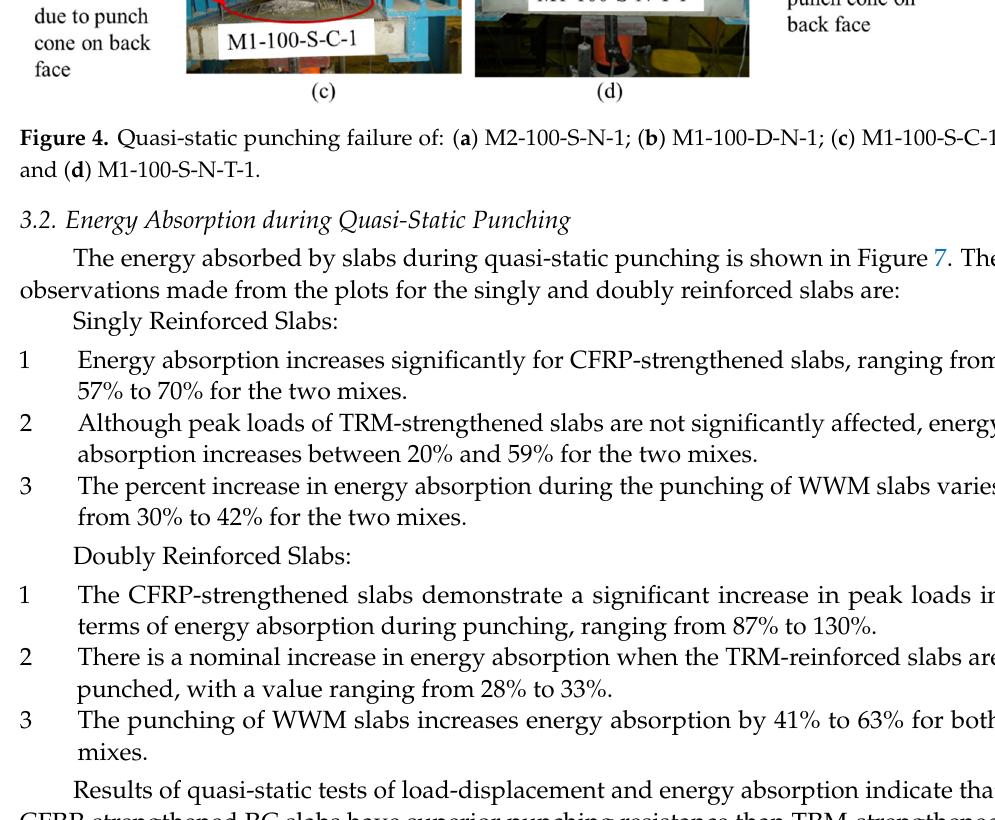
Figure 4. Quasi-static punching failure of: ( a ) M2-100-S-N-1; ( b ) M1-100-D-N-1; ( c ) M1-100-S-C-1; and ( d ) M1-100-S-N-T-1.